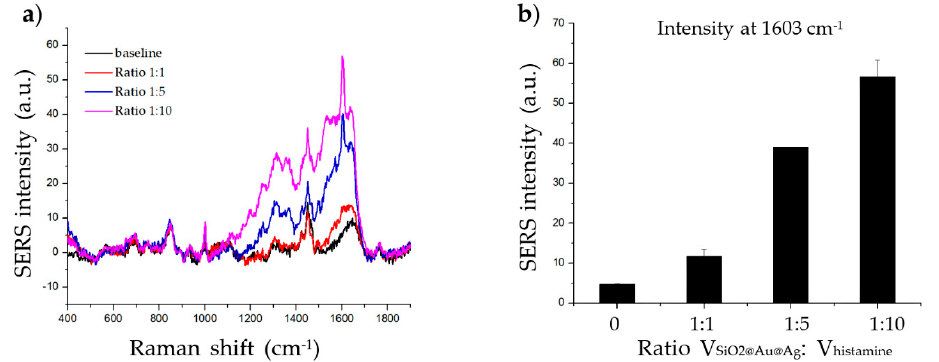
Figure 2. Effect of target volume on histamine detection. ( a ) Raman signal of histamine incubated